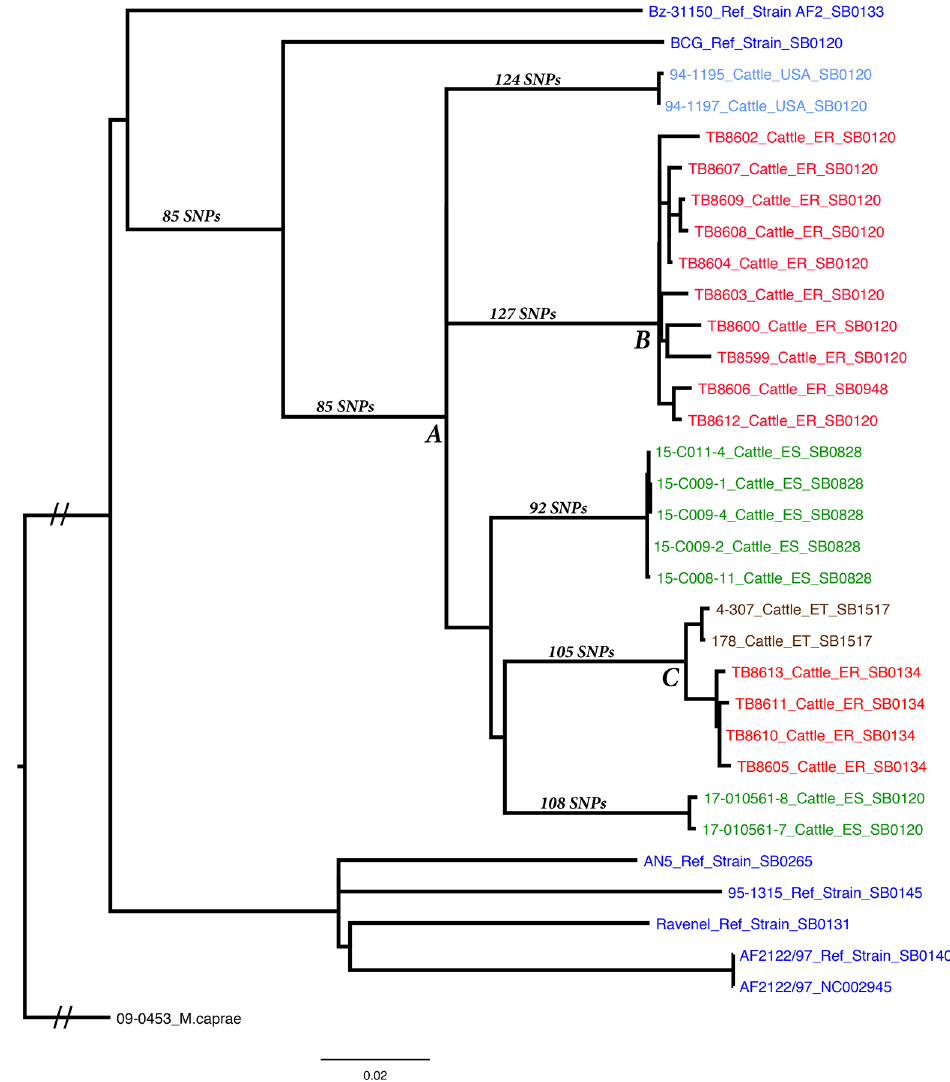
Fig 2. Whole genome sequence phylogenetic tree created using RAxML of 14 Eritrea dairy cattle abattoir samples and other field isolates that happen to share the same common ancestor with Eritrean isolates in the National Veterinary Services Laboratories’ database. These include cattle isolates from Ethiopia, United States and Spain. Also included in the tree are well known type strains, including BCG, Bz-31150 –a recently sequenced AF2 strain, AN5 – used in PPD production, 95–1315 –Michigan deer strain, Ravenel and